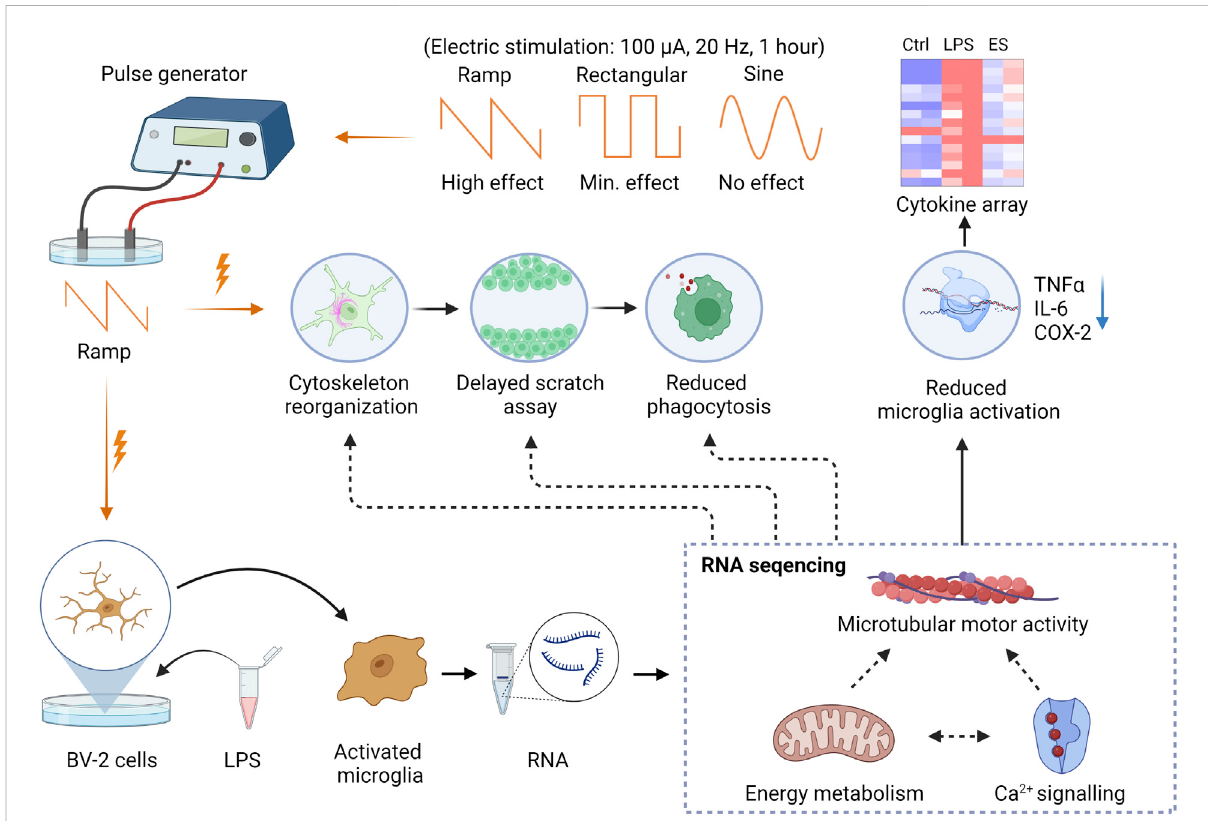
FIGURE 6 Graphical summary of the study fi ndings. The Ramp ES affects the cytoskeletal organization, reducing cell motility in the scratch assay and phagocytosis. Rectangular and sine waveforms do not appear to have a prominent effect on cytoskeleton, motility, and phagocytosis. Ramp stimulation also reduces pro-in fl ammatory microglia activation and cytokine release by the BV-2 cells. RNA sequencing indicates genes ’ downregulation in regulating cell migration, energy metabolism, and Ca 2+